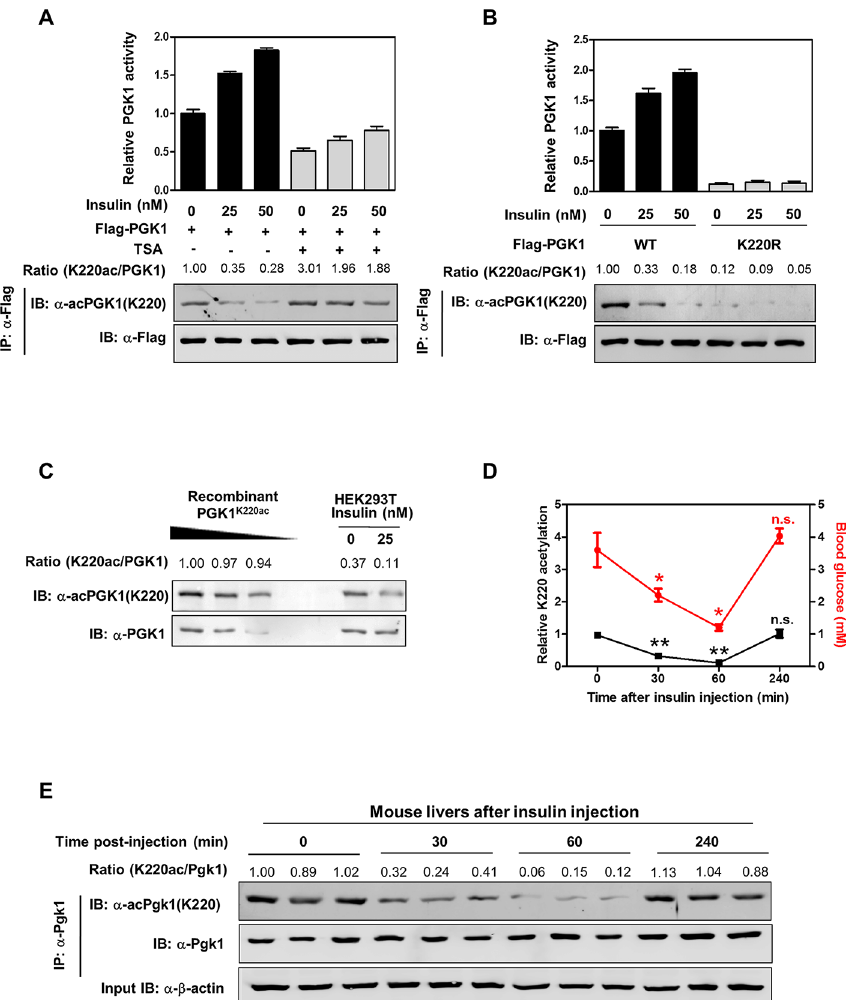
Fig 4. Insulin promotes K220 acetylation to stimulate PGK1 activity. ( A ) TSA treatment blocks the effect of insulin on changing PGK1 K220 acetylation and enzyme activity. Flag-tagged PGK1 was ectopically expressed in HEK293T cells treated with increased concentrations of insulin as indicated, and these cells were co-treated with or without TSA (5 μ M for 12 hr). PGK1 proteins were purified by Flag beads. The K220 acetylation levels and enzyme activity were determined by western blot analysis and enzyme assay, respectively. Relative K220 acetylation levels were normalized against Flag. ( B ) K220R mutant PGK1 displays a negligible response in changing K220 acetylation and enzyme activity upon insulin treatment. Flag-tagged wild-type or K220R mutant PGK1 were transiently overexpressed in HEK293T cells treated with increased concentrations of insulin as indicated. PGK1 proteins were purified by Flag beads. The K220 acetylation levels and enzyme activity were determined by western blot analysis and enzyme assay, respectively. Relative K220 acetylation levels were normalized against Flag. ( C ) Quantification of the percentage of K220 acetylated endogenous PGK1 in HEK293T cells. Recombinant fully K220 acetylated PGK1 was loaded onto the same gel, together with endogenous PGK1 from HEK293T cells treated without or with insulin (25 nM, 2 hr). PGK1 protein and K220 acetylation were detected by western blot. Relative PGK1 K220 acetylation levels were normalized against endogenous PGK1. ( D, E ) Quantification of the percentage of K220 acetylated endogenous Pgk1 in mouse livers. Insulin (5 U/kg) was intraperitoneally injected into wild- type mice, and blood glucose levels were measured at the indicated time points after injection. Mouse livers were harvested at the indicated time points post injection, and the K220 acetylation levels of endogenous Pgk1 were determined by western blot. Relative Pgk1 K220 acetylation levels were normalized against endogenous Pgk1. Shown are average values with standard deviation (S.D.) of triplicated experiments. * denotes p < 0.05 and ** denotes p < 0.01 versus t = 0 (before injection); n.s. = not significant. The numerical data and statistical analysis used in the figures are included in S1 Data. Supporting information can be found in S6